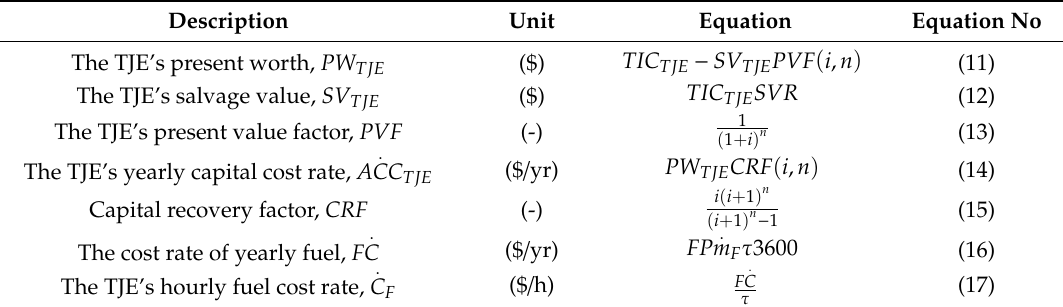
Table 2. The cost methodology algorithms of the